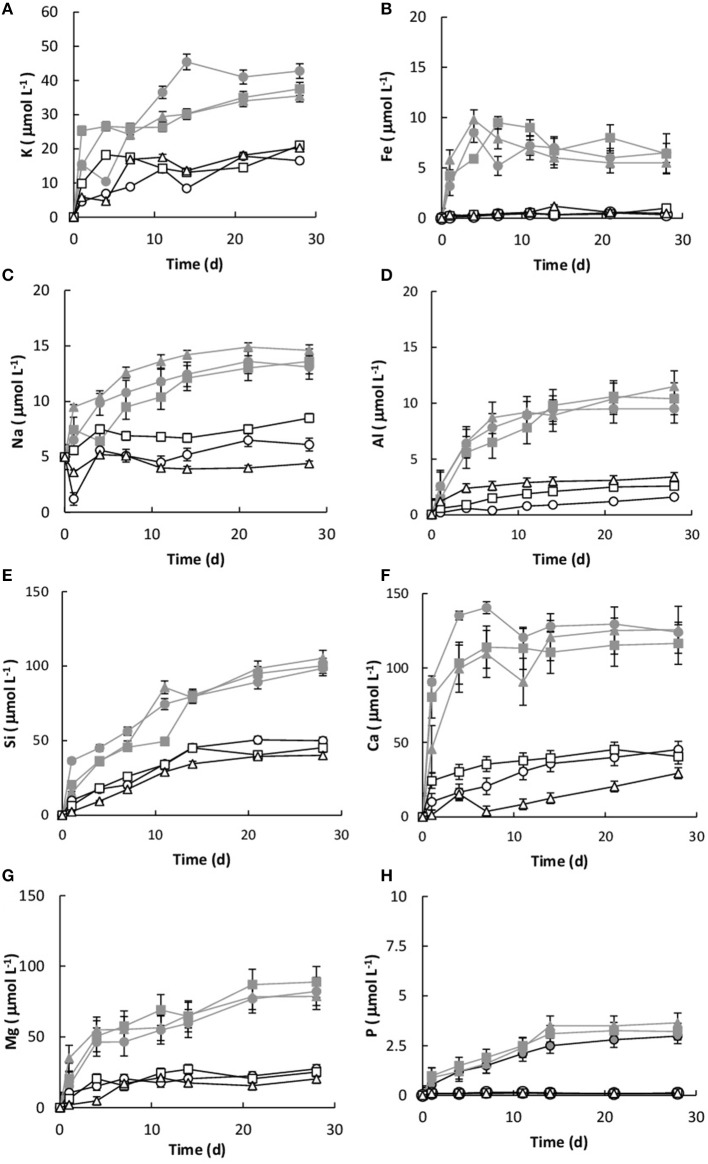
Concentration of K (A), Fe (B), Na (C), Al (D), Si (E), Ca (F), Mg (G), and P (H) over time for both the biotic [B1 (), B2 (), B3 ()] and abiotic flasks [C1 (□), C2 (∆), C3 (○)]. The values reported are the means of three independent experiments, and the standard error associated with these determinations is shown.